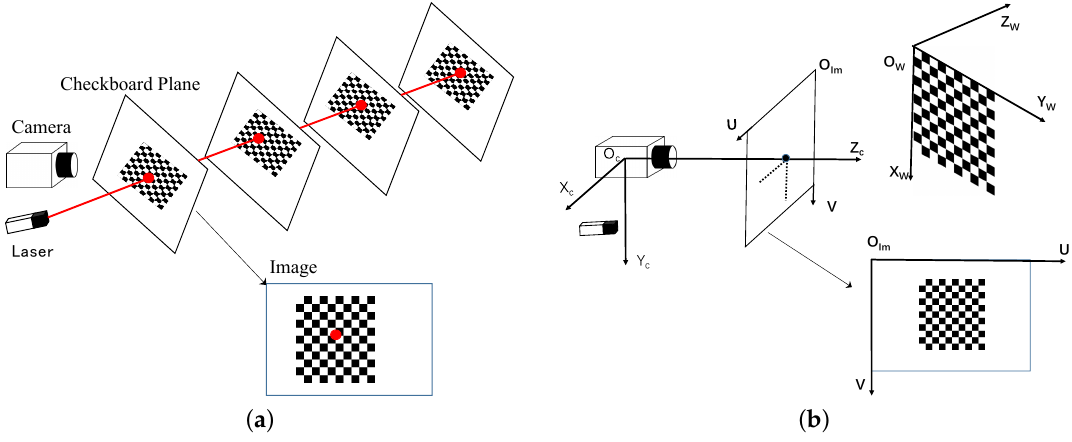
Figure 2. Illustration of the proposed calibration method: ( a ) design of the proposed calibration method; ( b ) diagram of the calibration reference coordinate